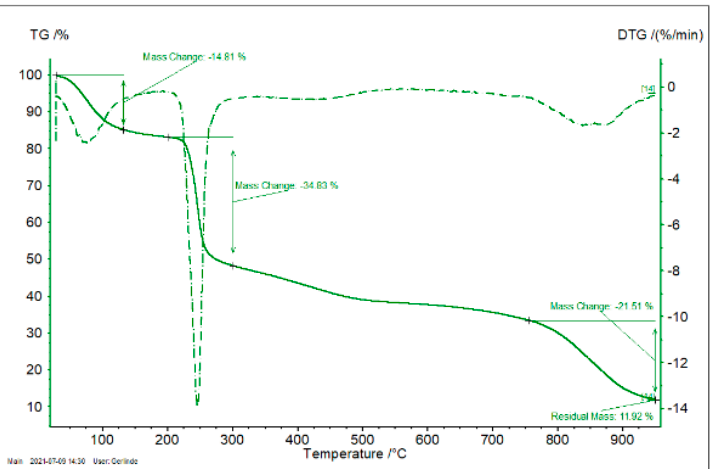
Figure 12. TG and DTG for